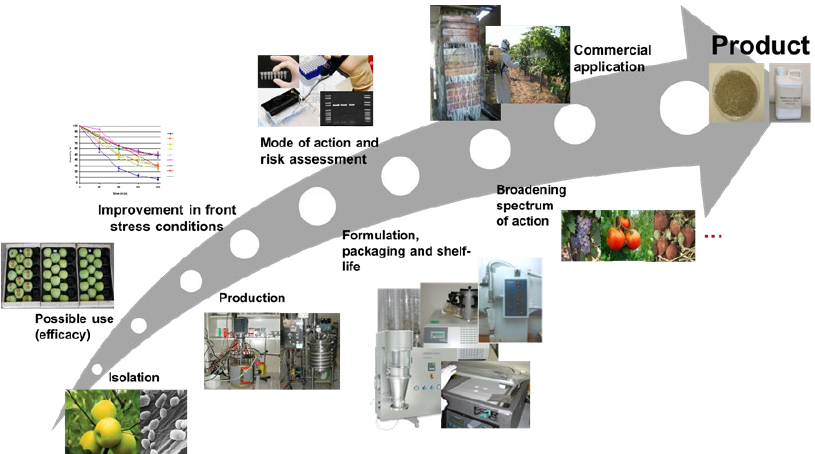
Figure 1. Different steps required in the development process of BCAs.